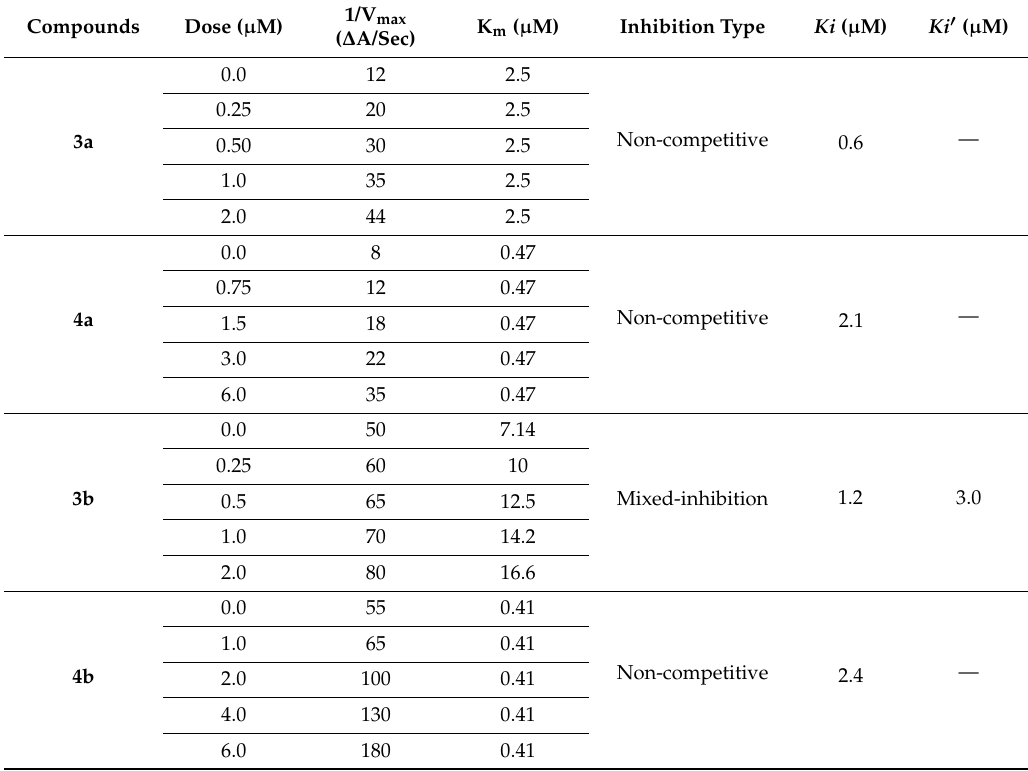
Table 4. Kinetic analysis of compounds, 3a , 4a , 3b , and 4b .